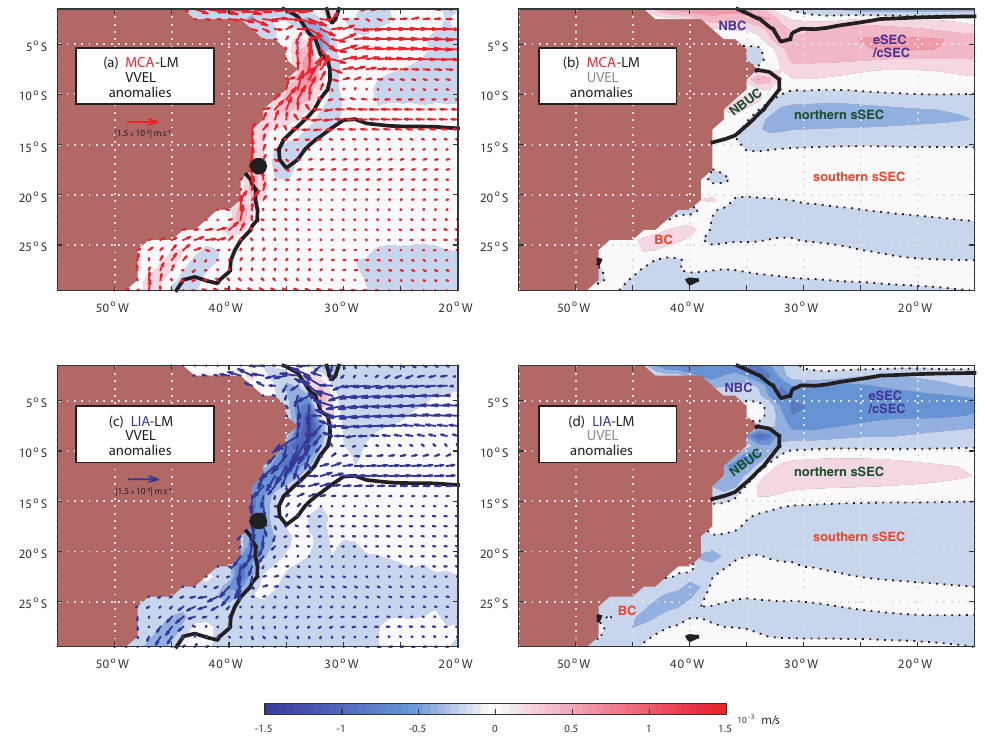
Figure 3. MCA and LIA anomalous SAO circulation pattern. Depth-integrated anomalous flows over the upper 200 m for the ( a , b ) MCA (950–1249) and ( c , d ) LIA (1400–1699) periods. ( a , c ) Anomalous horizontal velocities (UVEL, VVEL, as vectors) superposed on the anomalous meridional velocities (VVEL, background colors). Red (blue) background colors denote positive, northward (negative, southward) anomalies. Black contours mark the LM-mean zero meridional velocity line, for reference, and the black dot represents the MCA/LIA-mean SBL at 25 m. ( b , d ) Anomalous zonal velocities (UVEL, background colors). Red (blue) background colors denote positive, eastward (negative, westward) anomalies. Black contours mark the LM-mean zero zonal velocity line, for reference. Indicated are the westward basin-wide currents (eSEC/cSEC, northern and southern sSEC) and western boundary currents (North Brazil Current (NBC), North Brazil Undercurrent (NBUC), and Brazil Current (BC)), identified in different colors according to their respective anomalous